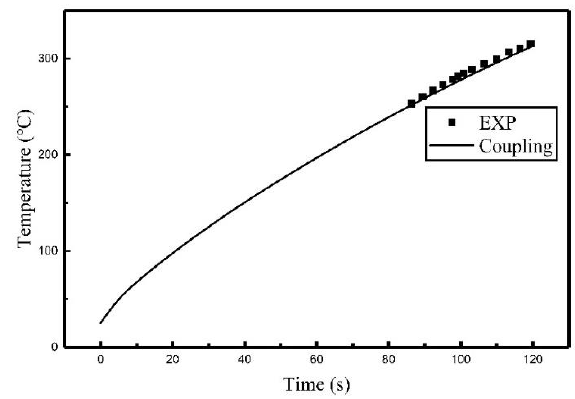
Figure 12. Comparison of the temperature histories of C 2 between the coupling model and the experiment. Materials 2019 , 12 , x FOR PEER REVIEW